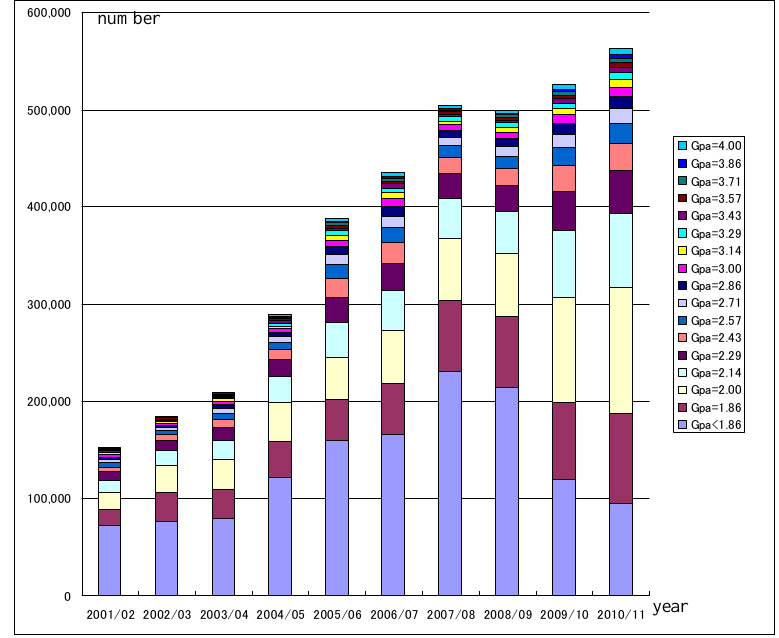
Figure 4-14: Trends of Results of Ethiopian General Secondary Education Certificate Examination (Grade 10) (2001/02 -